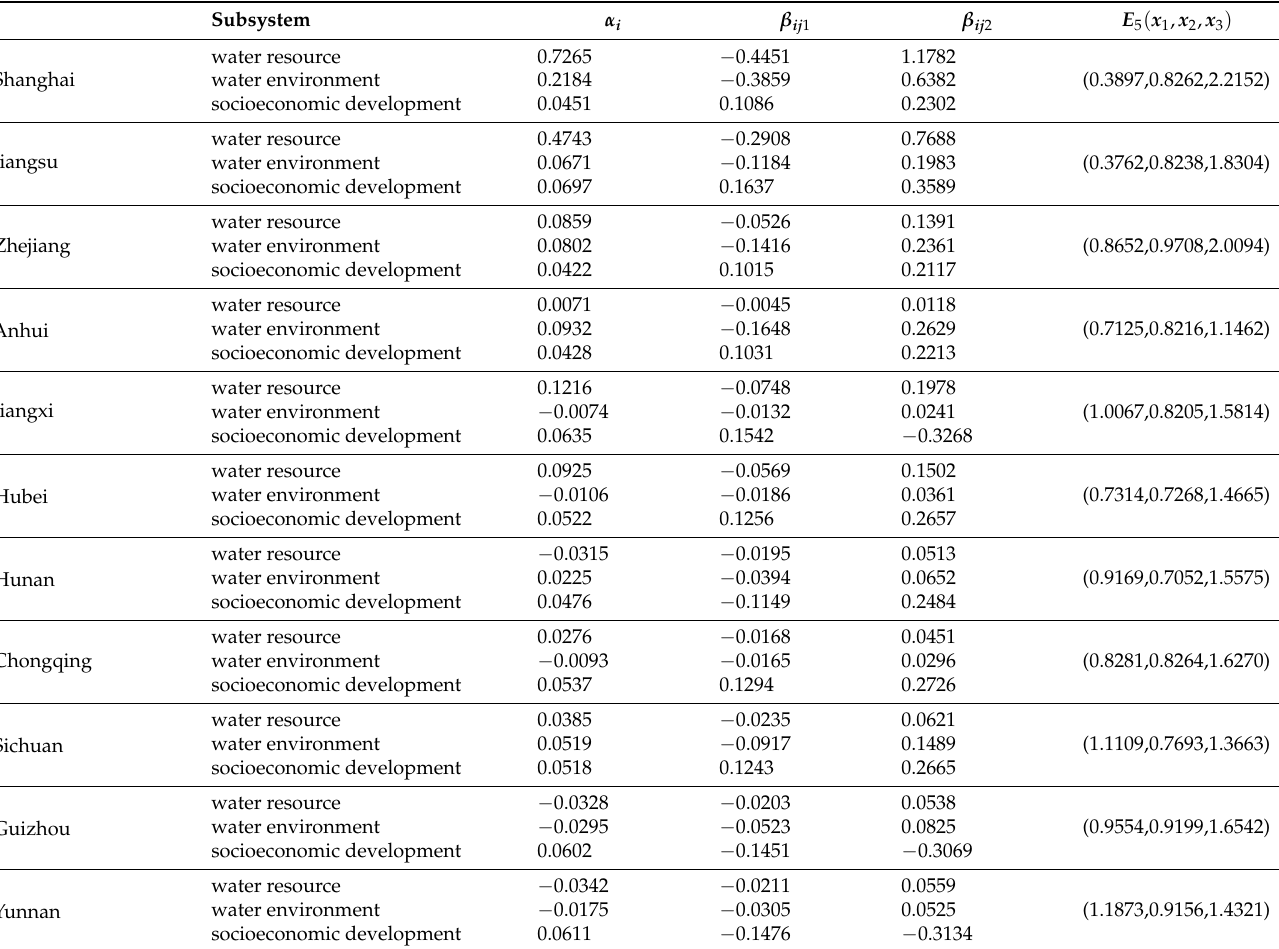
Table 8. Parameters estimation results and stable points in 11